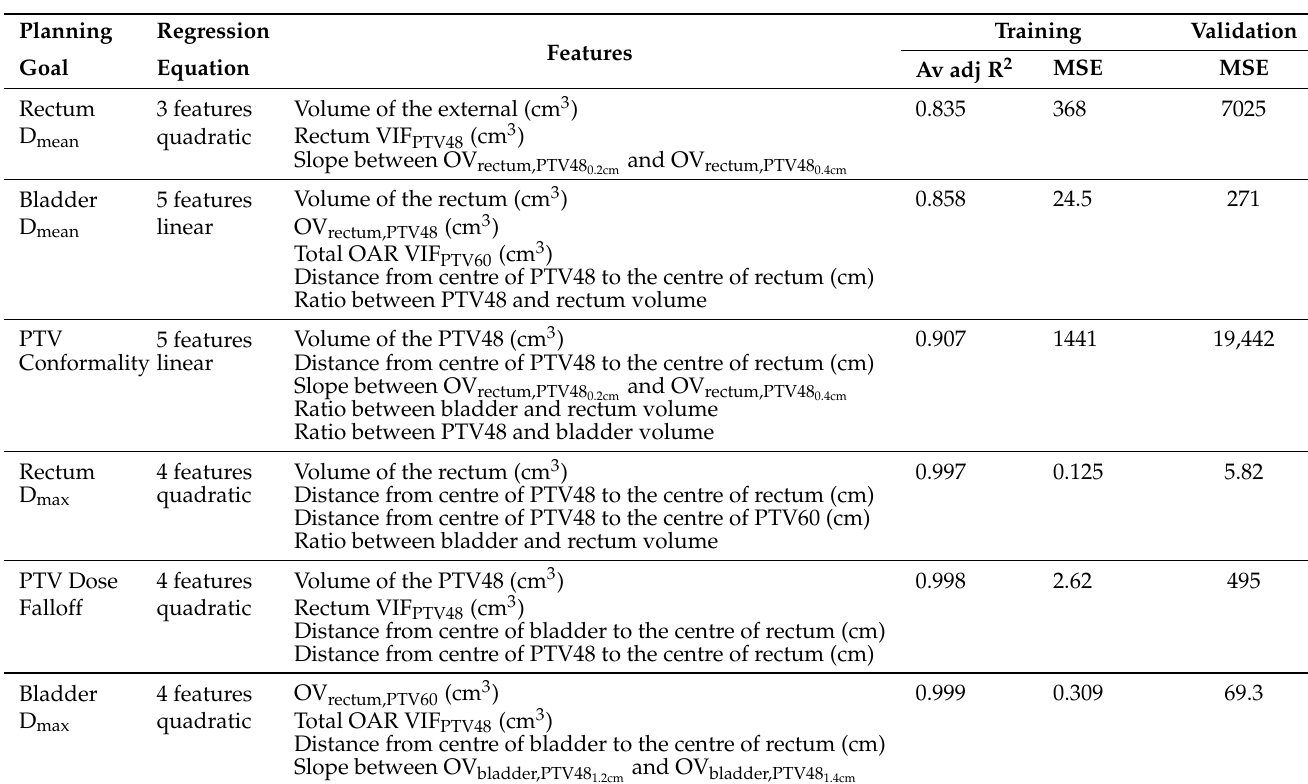
Table 6. Summary of PGAP-ML reg model formations defined during the automated leave-one out process.